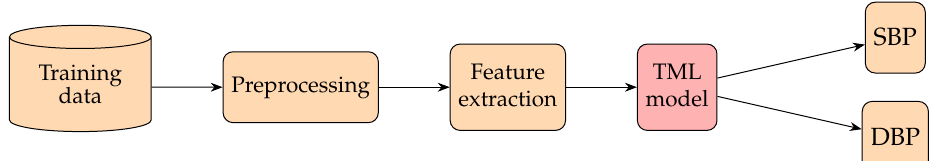
Figure 15. A pipeline of traditional machine learning (TML) methods for rPPG signals adopted in [220,223]. Those rPPG training data are initially preprocessed. Those relevant features of the filtered signals are extracted manually to feed their target models to predict SBP and